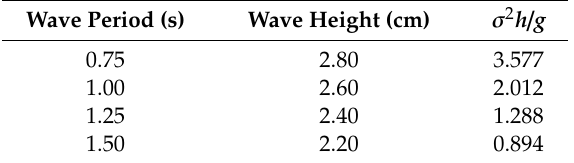
Figure 3. The model of the crescent plate in the basin. Table 2. Experimental regular wave conditions and their corresponding dimensionless counterparts.